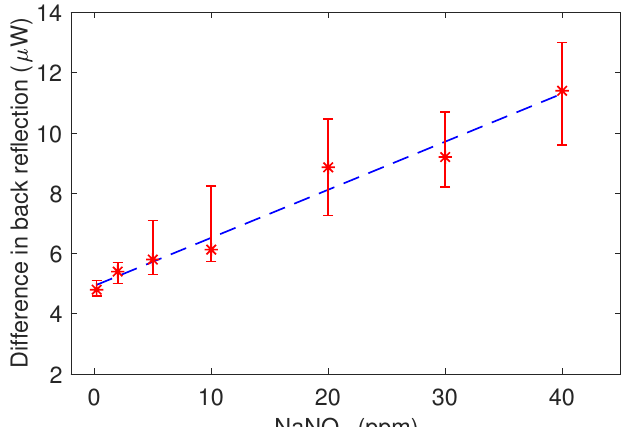
Figure 4. Characterization of the sensor. The difference in back reflection power from the PEDOT layer before and after exposure to nitrate is plotted against the NaNO − stars with error bars represent the experimental data and the blue dashed line represents the linear regression fit with a coefficient of determination of